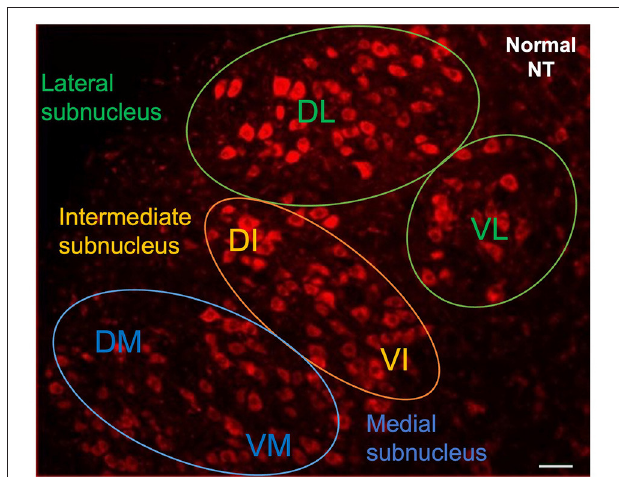
FIGURE 2 | Neurotrace counterstaining of facial motoneurons in contralateral side following injection into whiskerpads. Letters indicate the names of subnuclei: VL, ventrolateral; DL, dorsolateral; DI, dorsal intermediate; VI, ventral intermediate; DM, dorsomedial; VM, ventromedial. Scale bars = 20 µ